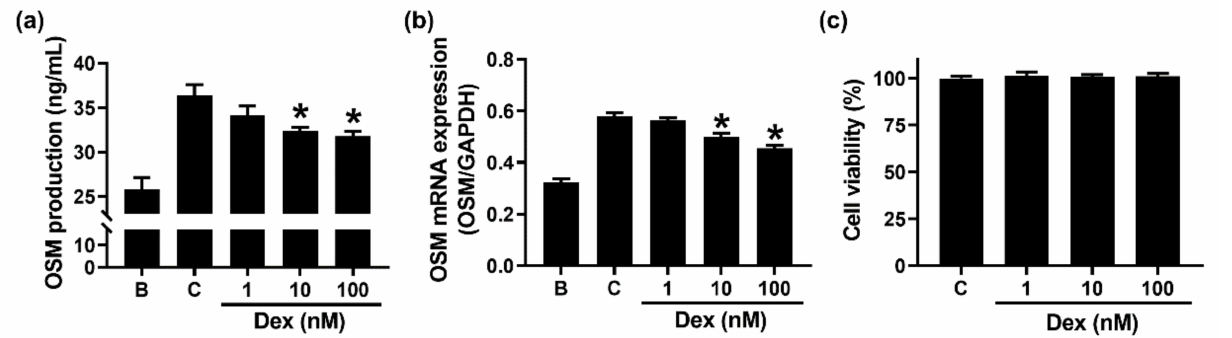
Figure 4. Effects of Dex on the production and mRNA expression of OSM in neutrophil-like dHL-60 cells. ( a ) dHL-60 cells (5 × 10 5 ) were pretreated with Dex (1 to 100 nM) for 1 h and then